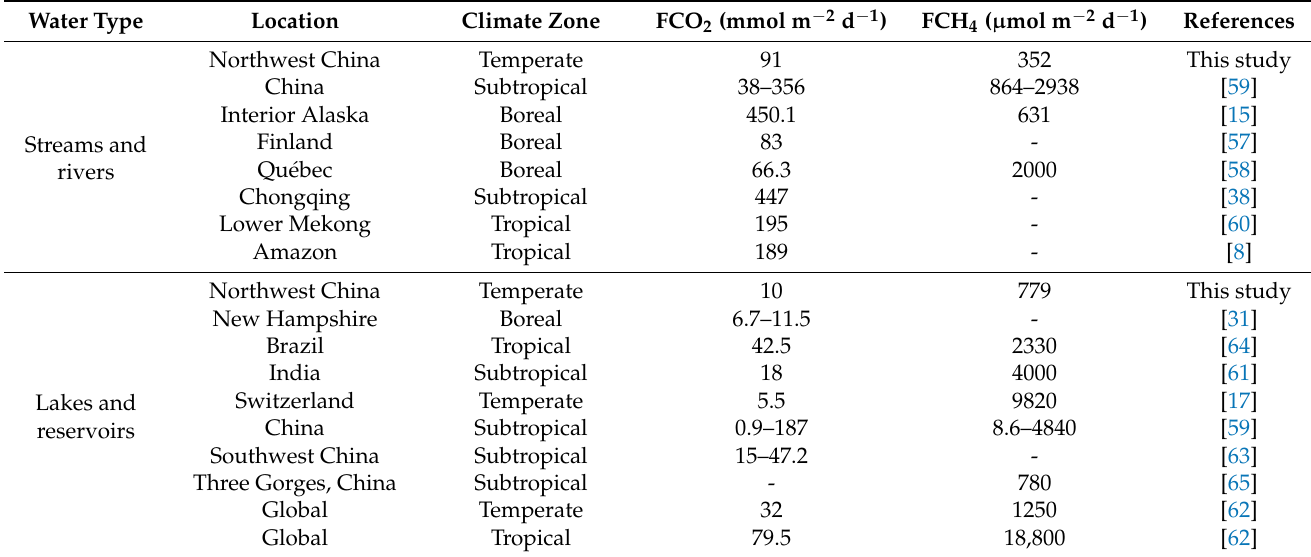
Table 3. Estimates of FCO 2 and FCH 4 inland water systems in the KRB and other parts of the world. Water